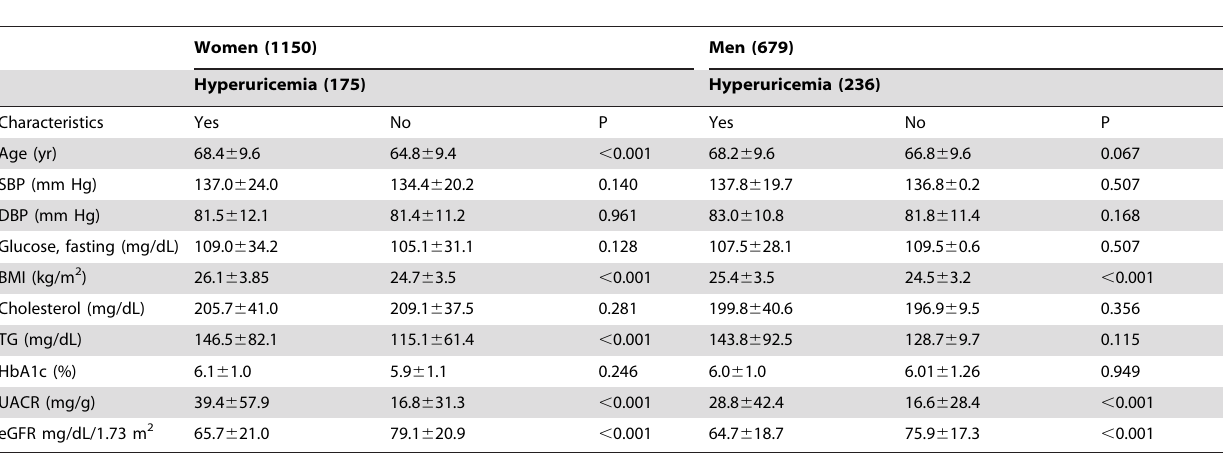
Table 2. Characteristics of study population according to hyperuricemia